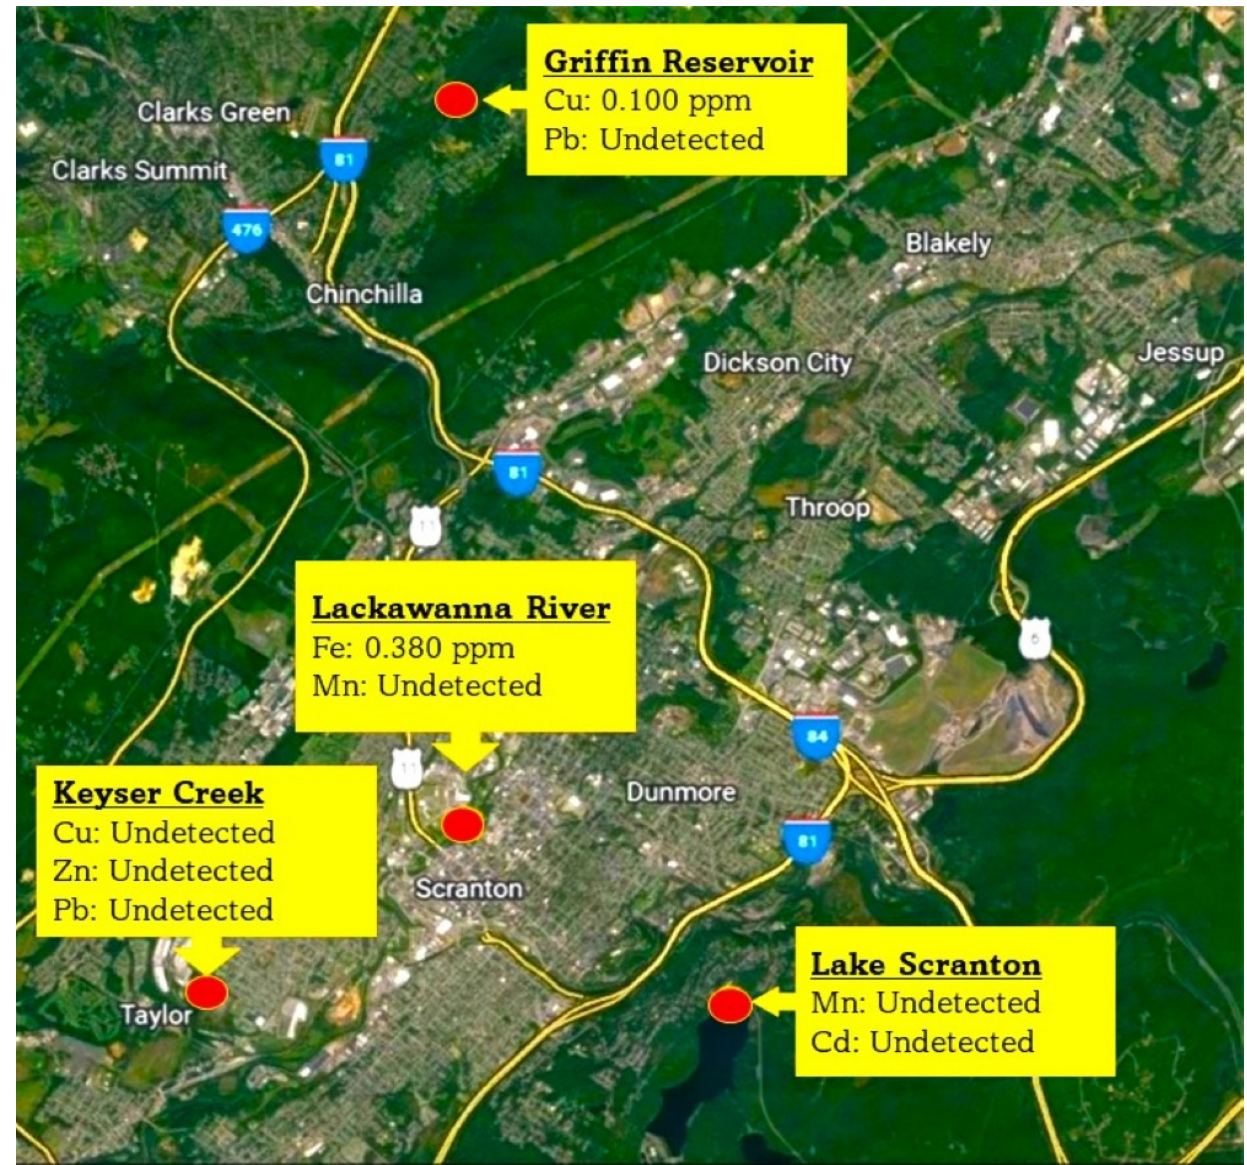
Figure 2. Map showing the concentrations of analyzed metals at each sampling site, which are indicated by the red circles.